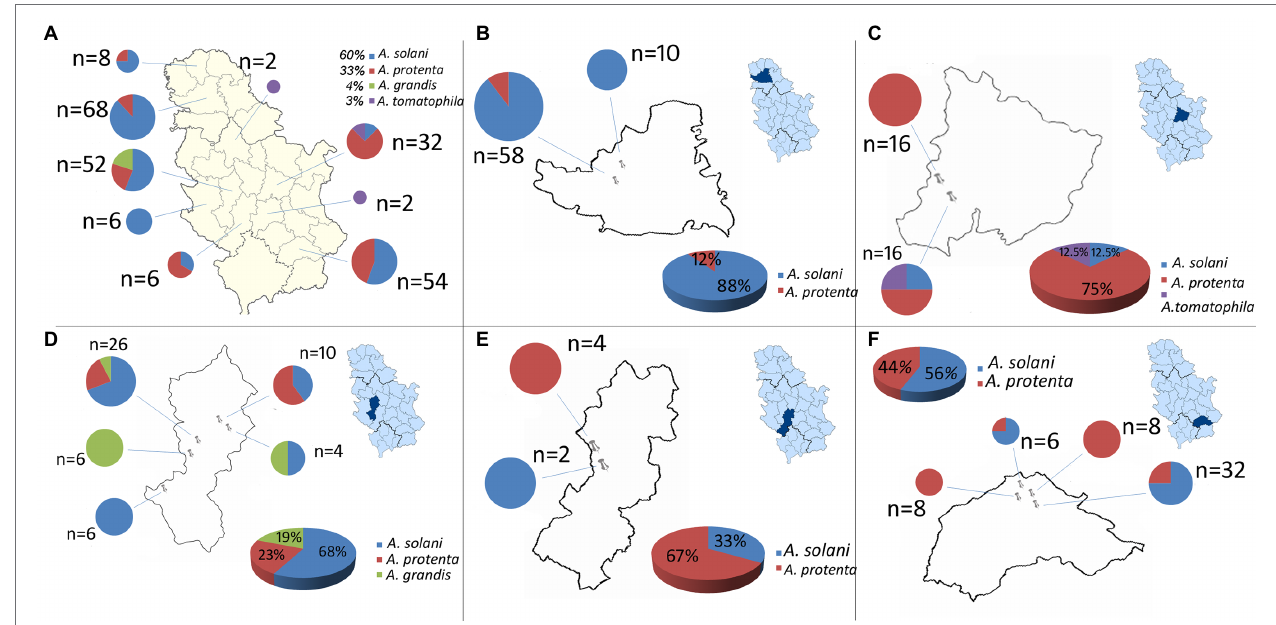
FIGURE 1 | Geographical distribution of large-spored Alternaria spp.: (A) Serbia, (B) South Bac ̌ ka district (localities: Maglic ́ , Kulpin), (C) Pomoravlje district (localities: Me đ urec ̌ , Dragocvet), (D) Moravica district (localities: Veles, Krivac ̌ a, Katic ́ i, Baluga, Zablac ́ e), (E) Raška district (localities: Bzovik, Rudno), and (F) Jablanica district (localities: Pec ̌ enjevce, Brejanovce, Navalin,